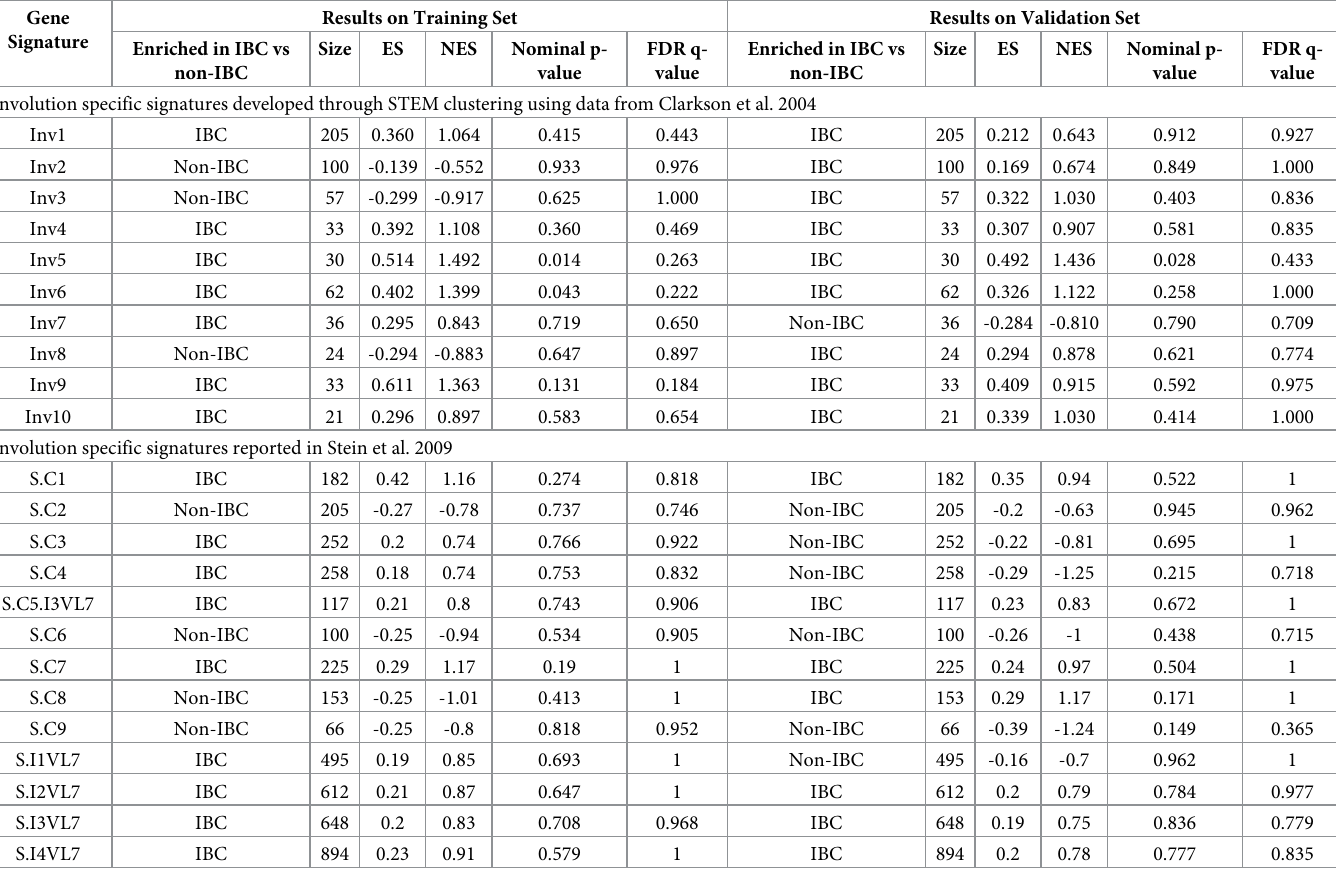
Table 3. GSEA results of involution-specific signatures in IBC versus non-IBC in the training and validation sets. Gene